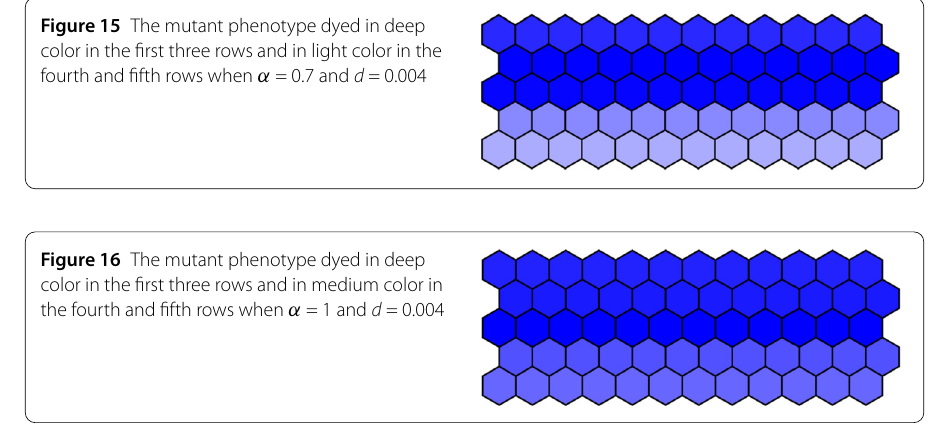
Figure 16 The mutant phenotype dyed in deep color in the first three rows and in medium color in the fourth and fifth rows when α = 1 and d =